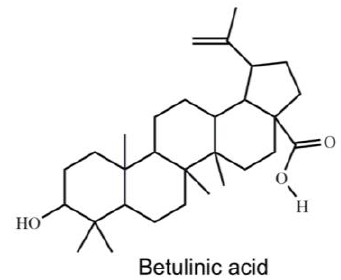
Figure 1. The chemical structure of